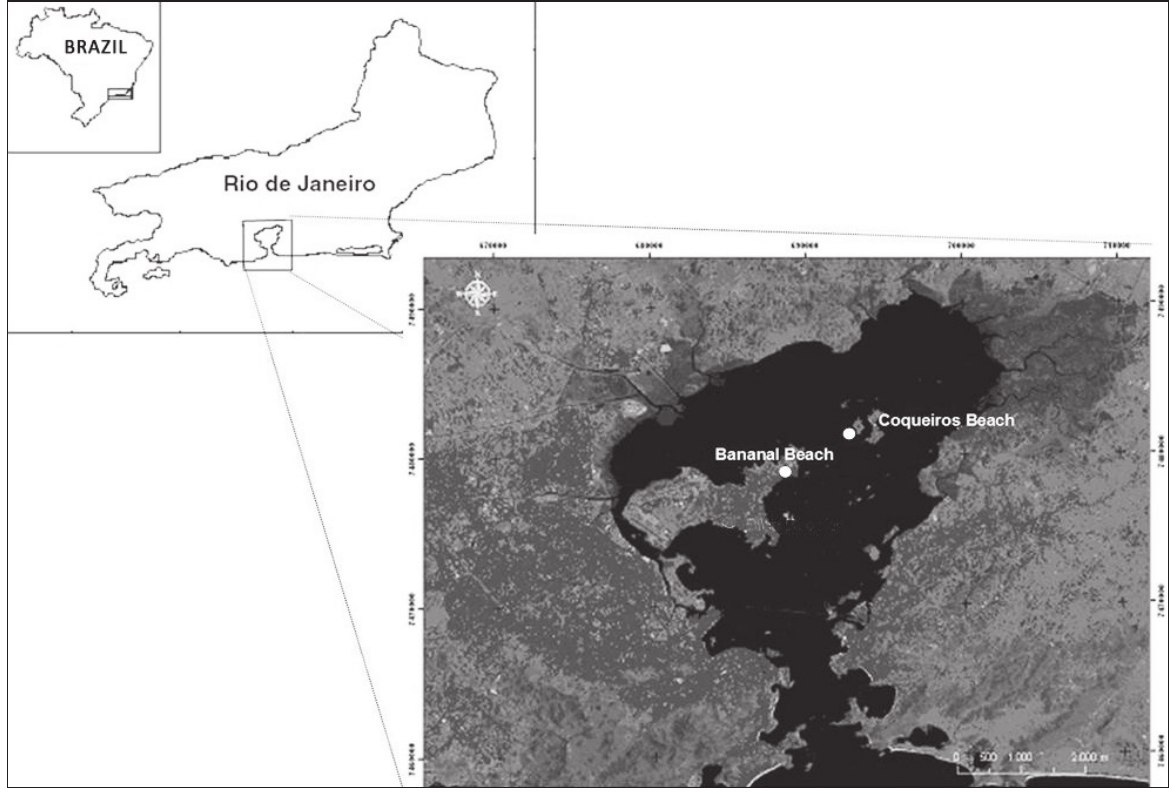
Fig. 1 - Guanabara Bay LANDSAT TM542 image, obtained by the Remote Sensing Laboratory of UFRJ. The locations of the beaches are indicated by white